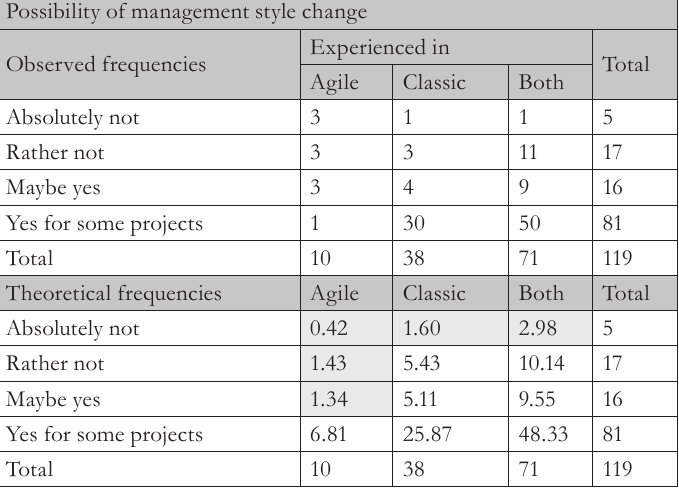
Tab. 4 – Results: Theoretical frequencies for the Chi-square test. Source: own research